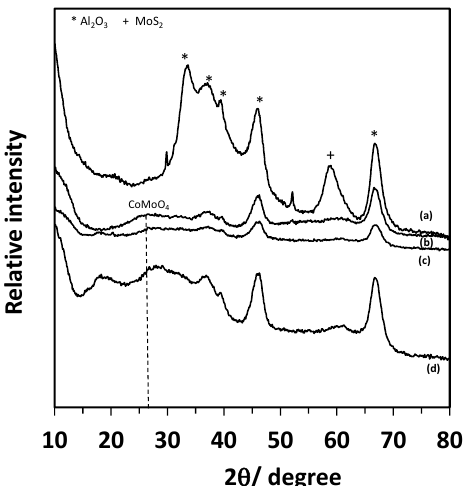
Figure 2. XRD patterns of the spent catalyst before ( a ) and after NTP (non-thermal plasma) treatment were carried out at 7 W at 200 °C during 5 ( b ), 10 ( c ) 20 min ( d ).